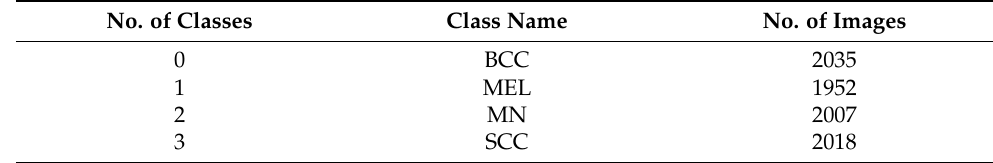
Figure 4. Architecture of proposed DSCC_Net used to classify skin cancer diseases. Table 4. The total number of parameters utilized in the proposed DSCC_Net model. Table 3. Image samples of the Skin Cancer dataset are distributed after up-sampling.